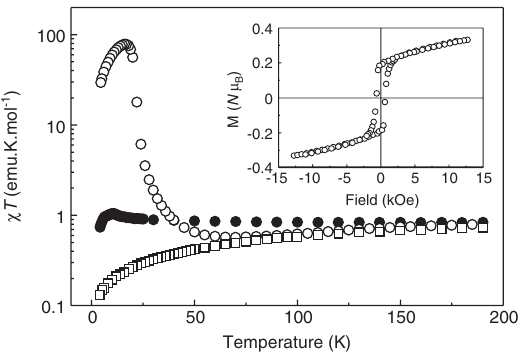
Figure 4: Examples of alkyl chain arrangement after exchange reaction in copper(II) or cobalt(II) basic salts (see text). Distances d and the tilt angle θ are directly related to the characteristic distance of the layer stacking (basal spacing) as deduced from powder X-ray diffraction patterns. Adapted with permission from [81]. Copyright 1999 Royal Society of Chemistry.